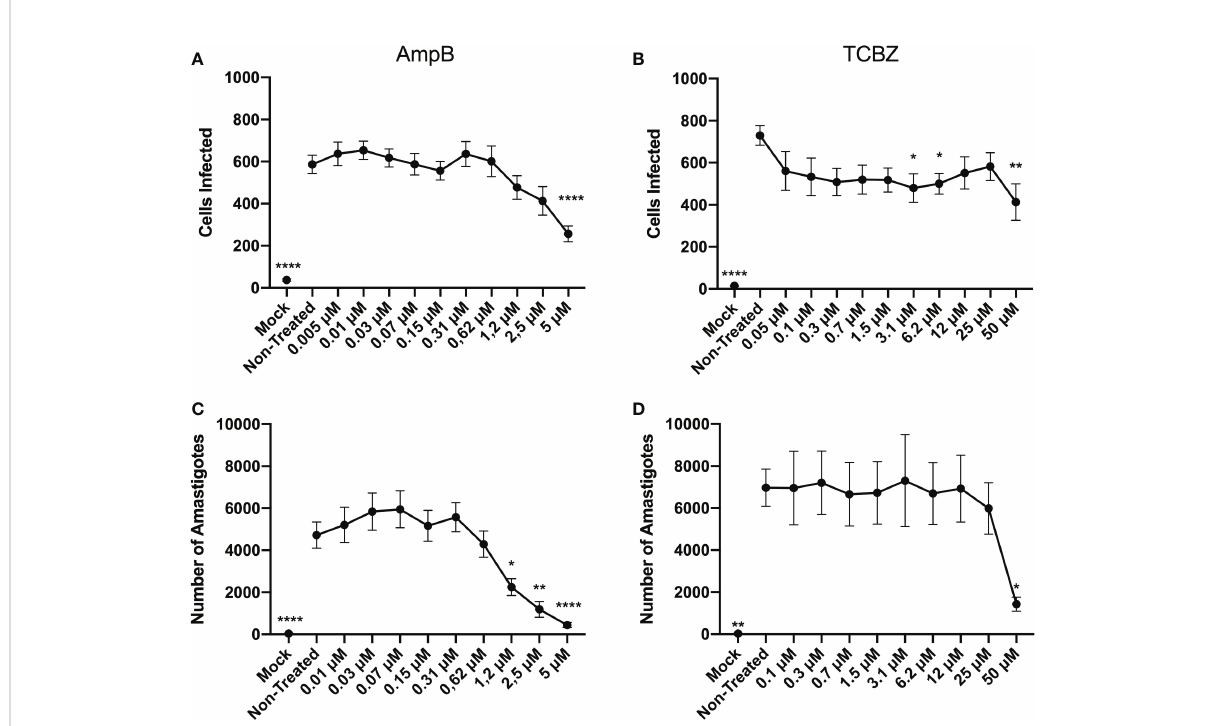
FIGURE 3 Anti-amastigote effect of AmpB and TCBZ at 48h of treatment. (A) Macrophages infected with L. amazonensis were treated for 48h in increasing concentrations of AmpB. Statistically signi fi cant results can be observed at 5 m M treatment. (B) Macrophages infected with L. amazonensis were treated for 48h in increasing concentrations of TCBZ. Statistically signi fi cant results can be observed at 3.1, 6.2, and 50 m M treatment. Mock cells (without parasite infection) were used as negative control in the Operetta System analysis. (C) Number of amastigotes in infected cells treated with AmpB for 48h. Statistically signi fi cant results can be observed from 1.2 m M. (D) Number of amastigotes in infected cells treated with TCBZ for 48h. Statistically signi fi cant results can be observed at 50 m M. * = p < 0.0332, ** = p < 0.0021, **** = p < 0.0001.